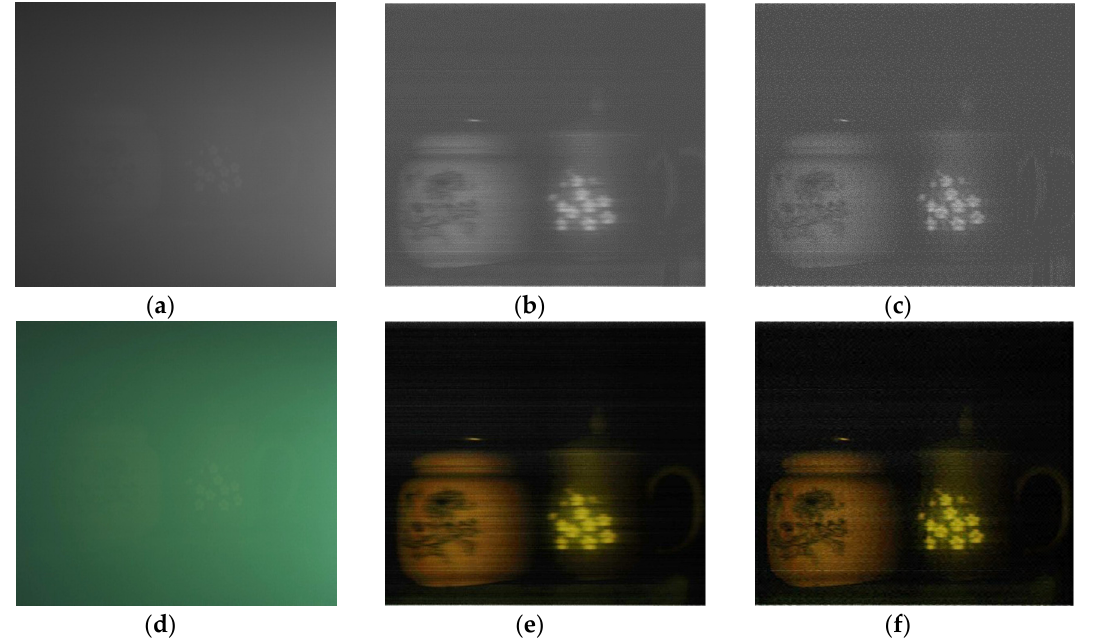
Figure 8. Experimental results of image recovery with heavy turbidity of water. ( a ) Floodlit gray level image; ( b ) Synthesized image after the removal of the back scattered light; ( c ) Result of blind deconvolution using the L–R method; ( d )–( f ) Colored versions associated with the same implementations as of (a)–(c) with respect to RGB channels, respectively.